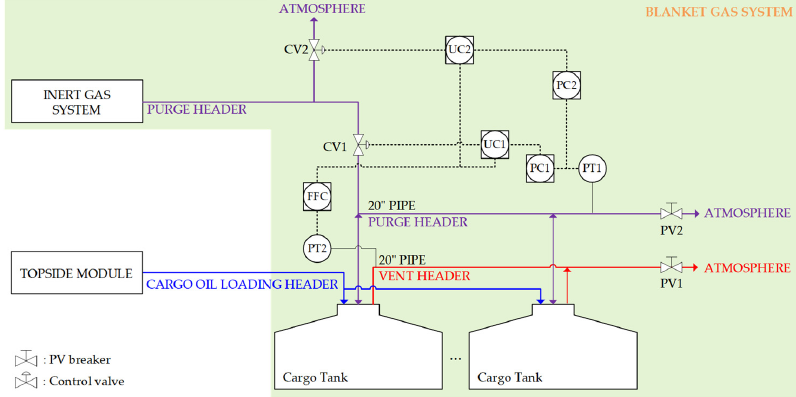
Figure 4. Configuration of a novel blanket gas system (Case